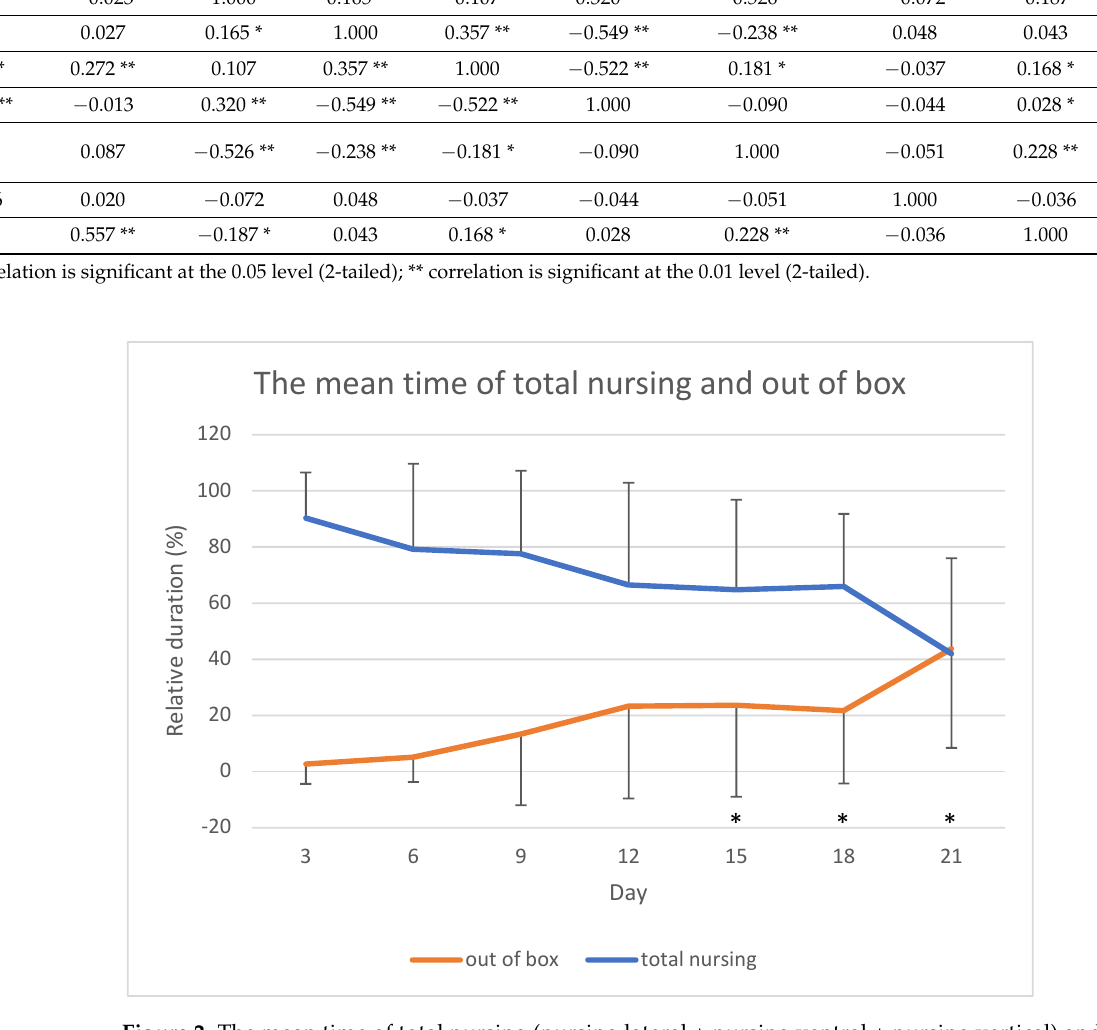
Figure 2. The mean time of total nursing (nursing lateral + nursing ventral + nursing vertical) and the mean time spent by the mothers out of box across observations. Error bars indicate standard deviation. * p < 0.05 versus days 3, 6 and 9.